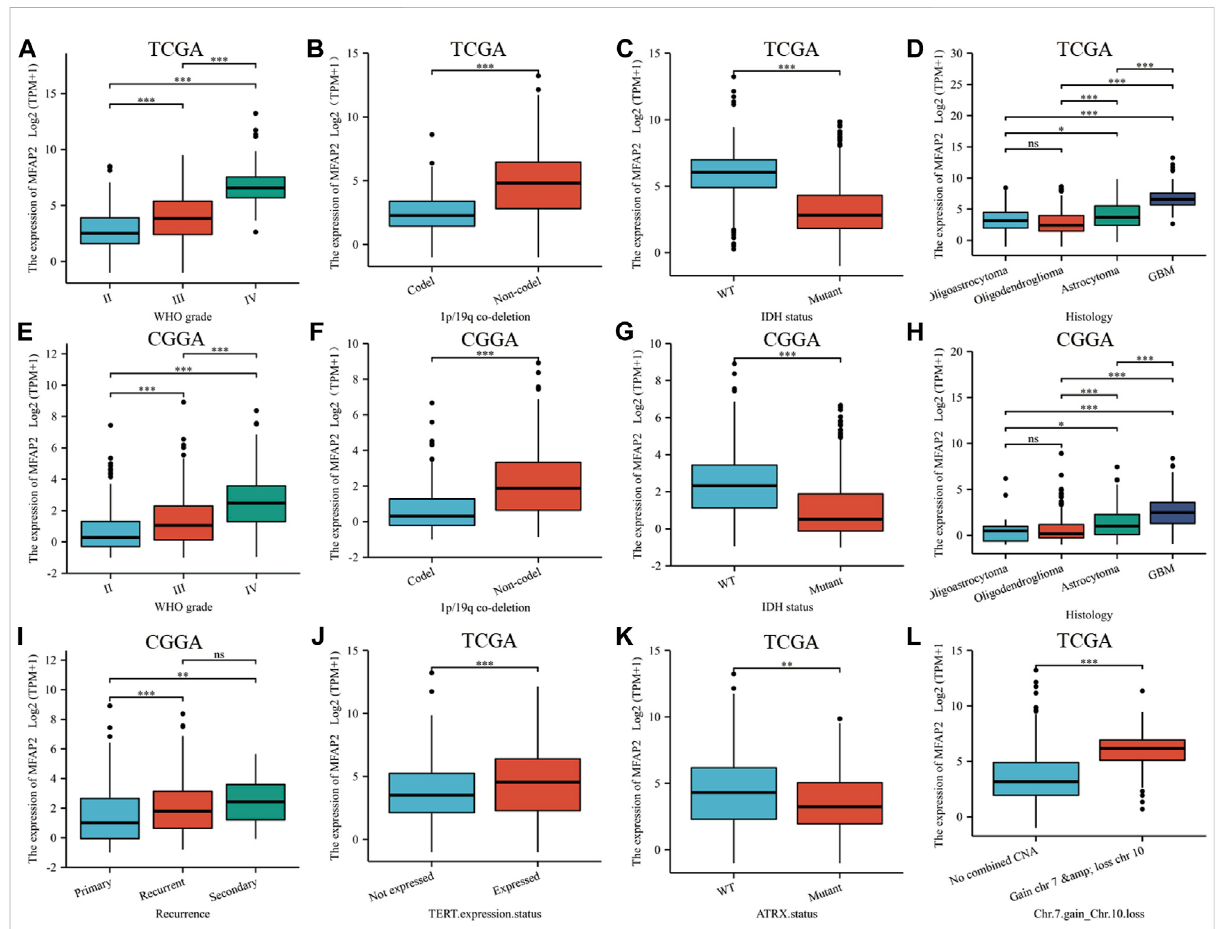
FIGURE 2 The association between MFAP2 expression and clinicopathologic features. MFAP2 expression patterns for different grades of glioma in TCGA (A) and CGGA (E) database. MFAP2 expression patterns for different co-deletions of 1p/19q in glioma in TCGA (B) and CGGA (F) database. MFAP2 expression patterns for different IDH status of glioma in TCGA (C) and CGGA (G) database. MFAP2 expression patterns for different histological types of glioma in TCGA (D) and CGGA (H) database. (I) MFAP2 expression patterns for glioma recurrence in CGGA database. (J – L) Relationship between MFAP2 expression and TERT expression status (J) , ATRT status (K) , and chromosomes 7 and 10 (L) in TCGA database. Codel, codeletion. Non-codel, non-codeletion. WT, wild type. p -value signi fi cance codes: *** p ≤ 0.001, ** p ≤ 0.01, * p ≤ 0.05. ns, not signi fi